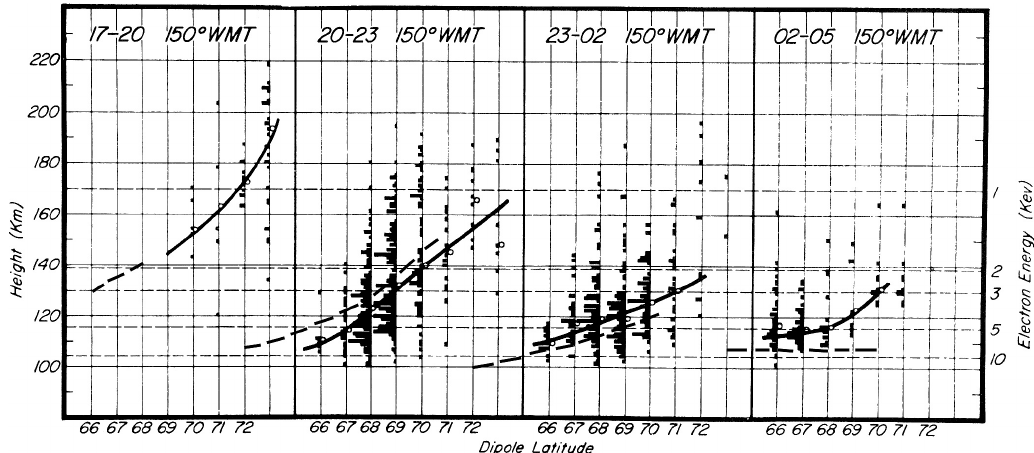
Fig. 7. Distribution if the height of the peak emission of 5577 ˚A [OI] emission as a function of dipole latitude for four 3-h time periods shown as 150 ◦ WMT (Boyd et al., 1971). Local magnetic midnight is approximately 01:15 150 ◦ WMT. The median point of the distribution in each latitude interval is shown by a circle. The dashed lines are median data from the complete 1960 data set, for comparison.